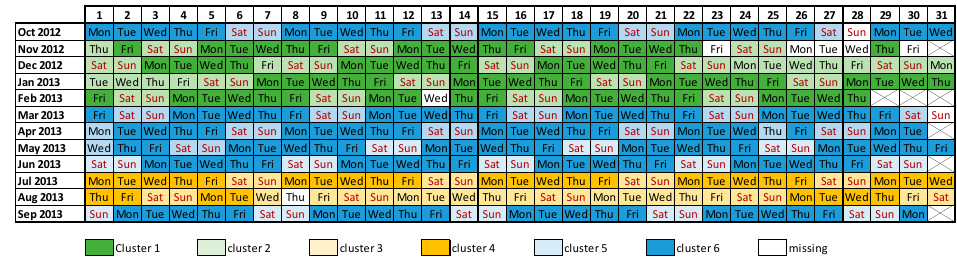
Figure 3. Cluster assignments over the observation period.